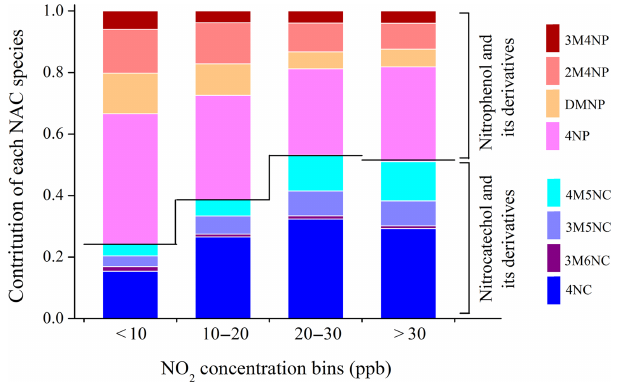
Figure 6. Variation of NAC composition as a function of NO 2 con- centration